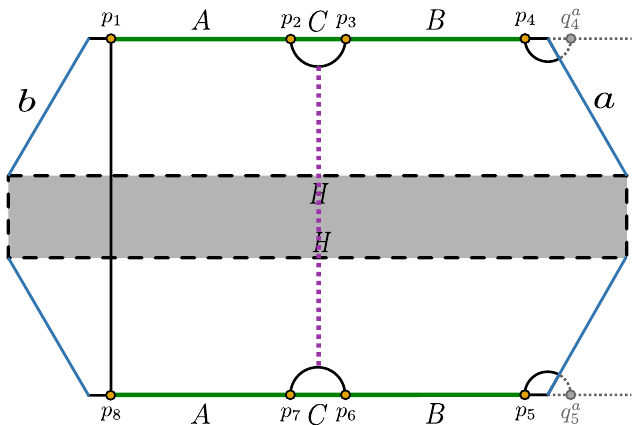
Figure 36 . The endpoints of the intervals A and B and the image points in the two BCFT 2 copies are identified similarly as in figure